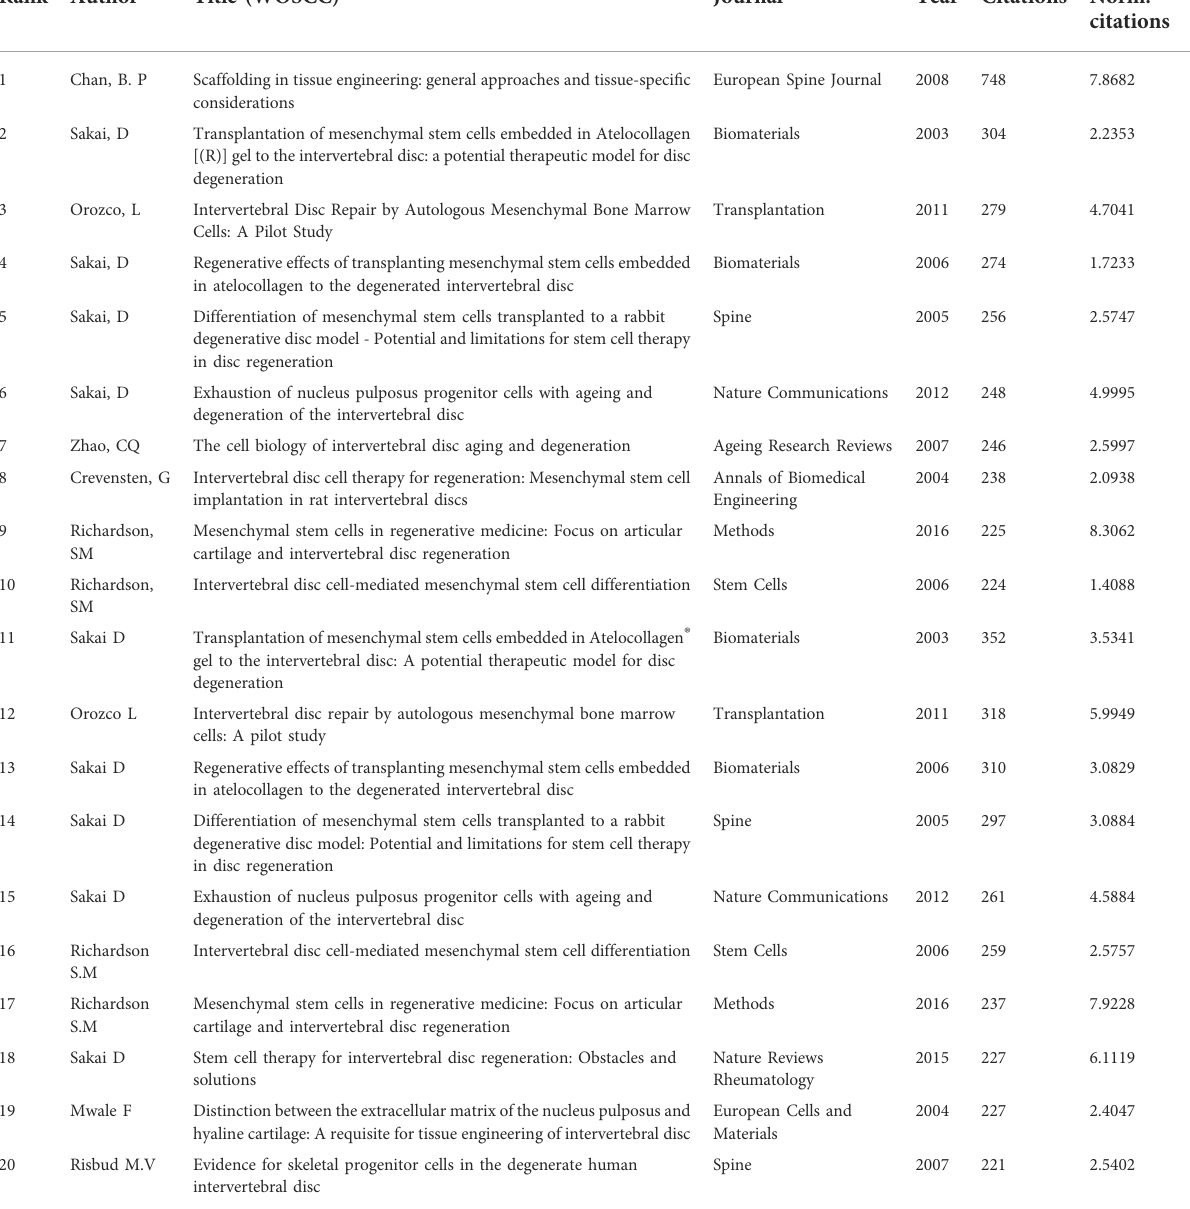
TABLE 4 Top 10 highly cited articles in the WOSCC and Scoups